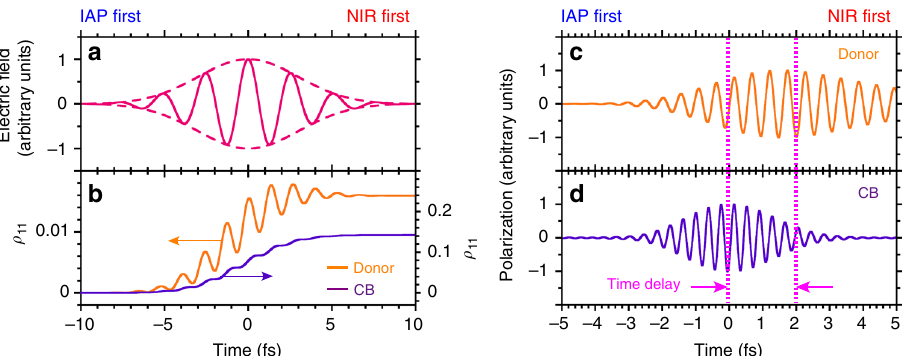
Fig. 4 Calculated time-dependent density matrix element and polarization. a The applied electric fi eld waveform of the pulse with 7-fs duration. b Populations of the excited state ( ρ 11 ) in the donor-like (5 ħ ω ) and CB (7 ħ ω ) resonances with parameter values of μ F / ħ ω = 0.59, τ CB = 0.2 fs and τ Donor = 3 fs. Fourier fi ltered polarizations in c donor-like and d CB resonances. The pink dotted lines and arrows show the time delay between the donor-like and CB